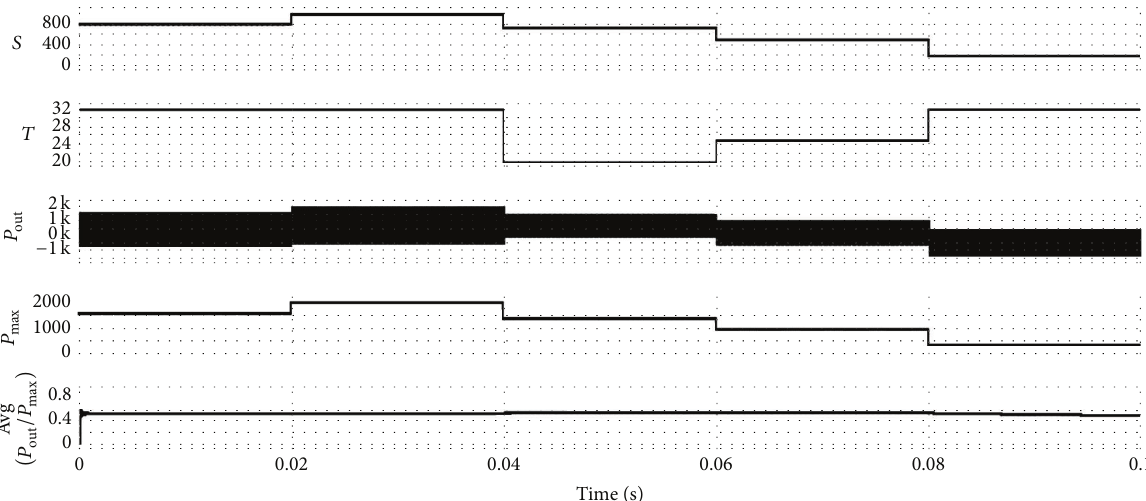
), theoretical value of the maximum extracted power ( 𝑃 max ), out